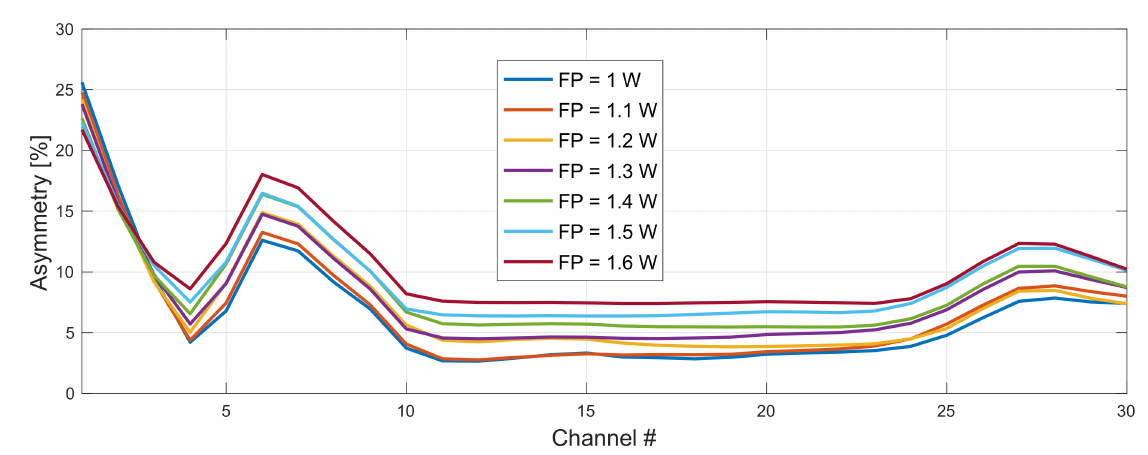
Figure 5. Impact of pump power choice (original WDM grid) on asymmetry performance. Forward pump power of the conjugated grid fixed to be 1.3 W. FBG for original and conjugated WDM grid was set to 1462 and 1446 nm, respectively.